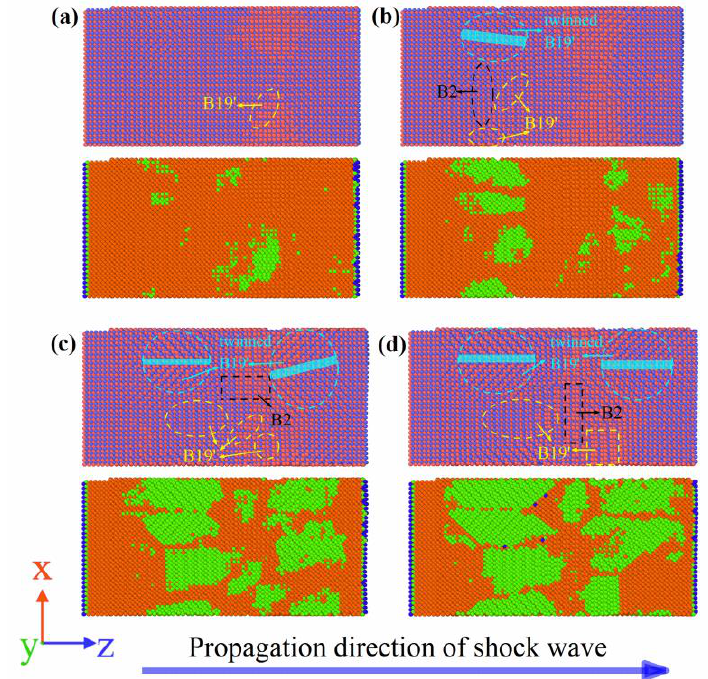
Figure 11. Martensitic transformation and twinning at Stage III : ( a ) 6.0 ps; ( b ) 8.2 ps; ( c ) 9.2 ps; ( d ) 10.2 ps. (Orange and green represent the B2 phase and B19′ phase, respectively, but blue represents the other phase).